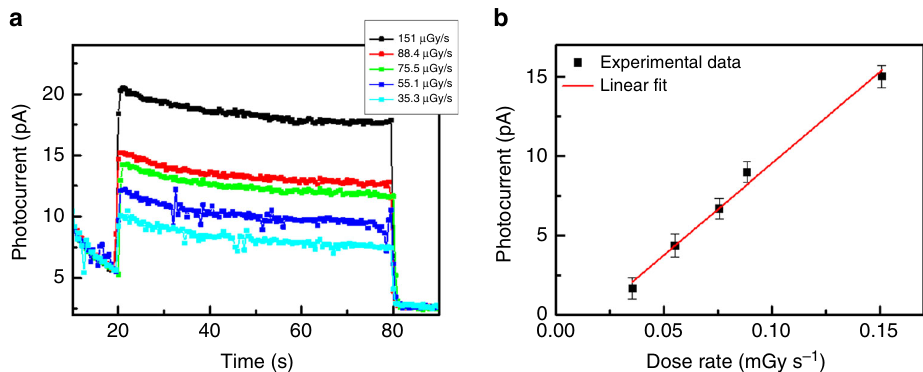
Fig. 5 Detector response at low X-ray dose rates. a X-ray induced photocurrent response of a TIPS-pentacene:PS 4:1 device at several dose rates, down to 35 µ Gy s − 1 . b Photocurrent versus dose rate, including the linear fi t used for the sensitivity calculation. The error bars refer to the statistical fl uctuations of the signal amplitude over three on/off switching cycles of the X-ray beam in the same